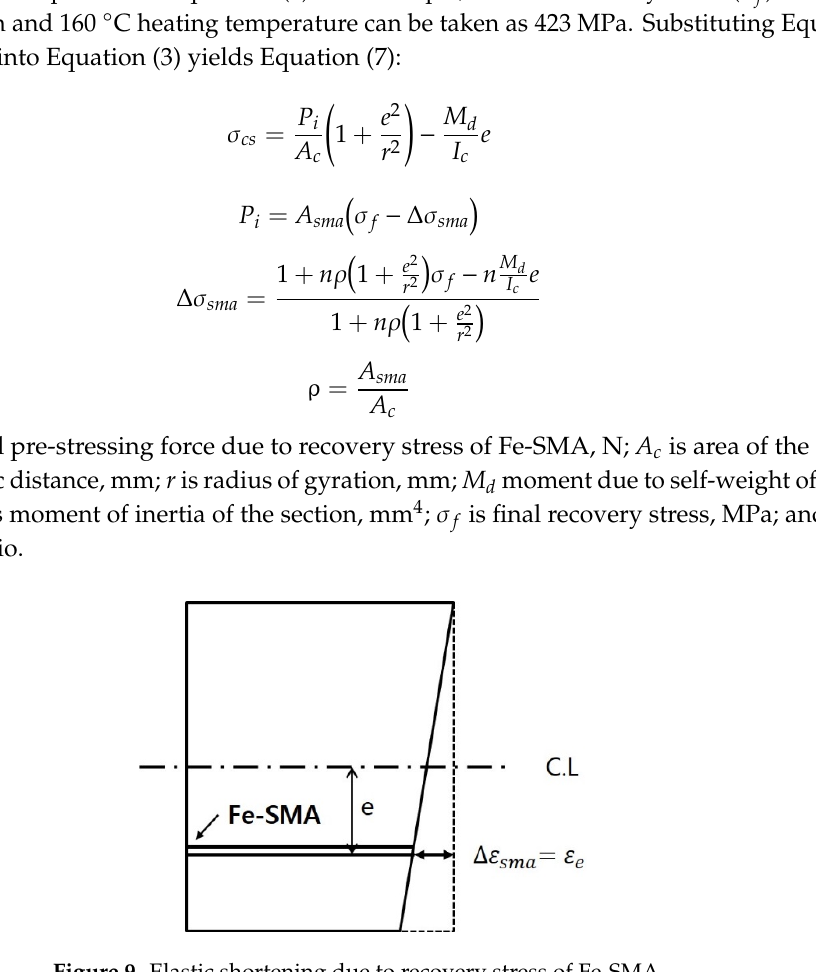
Figure 9. Elastic shortening due to recovery stress of Fe ‐ SMA.